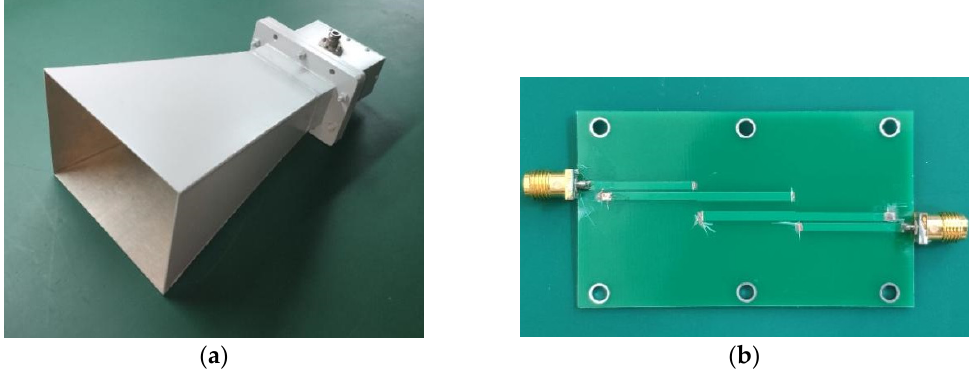
Figure 2. Wireless RF front-end circuits: ( a ) Pyramid horn antenna; ( b ) micro-strip band pass filter.